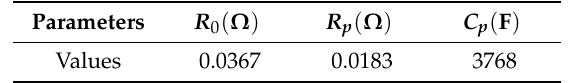
Table 6. Reference values of 1-RC model parameters in 25 °C at 98% SOC level.